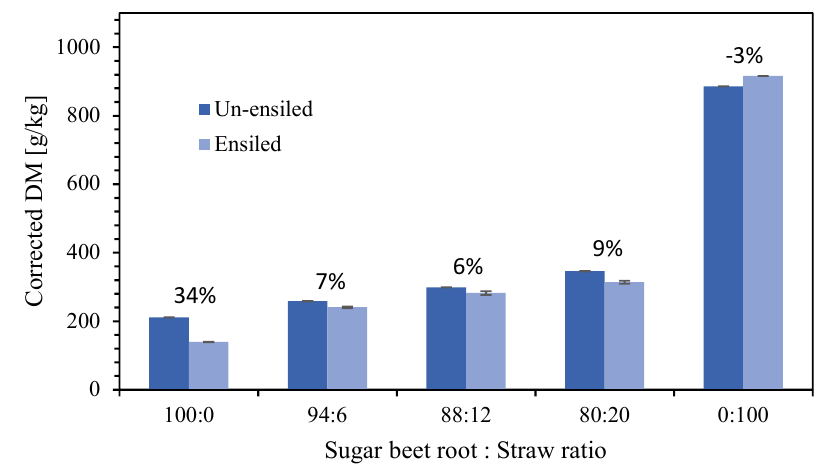
Figure 2. Corrected dry matter (DM) concentration of mixtures of sugar beet root and wheat straw at different ratios (WW) before and after ensiling (8 months). Wheat straw would not ensile due to its high dry matter concentration and is therefore only stored for 2 months. The relative DM loss during ensiling is listed above the columns. The error bars indicate the standard